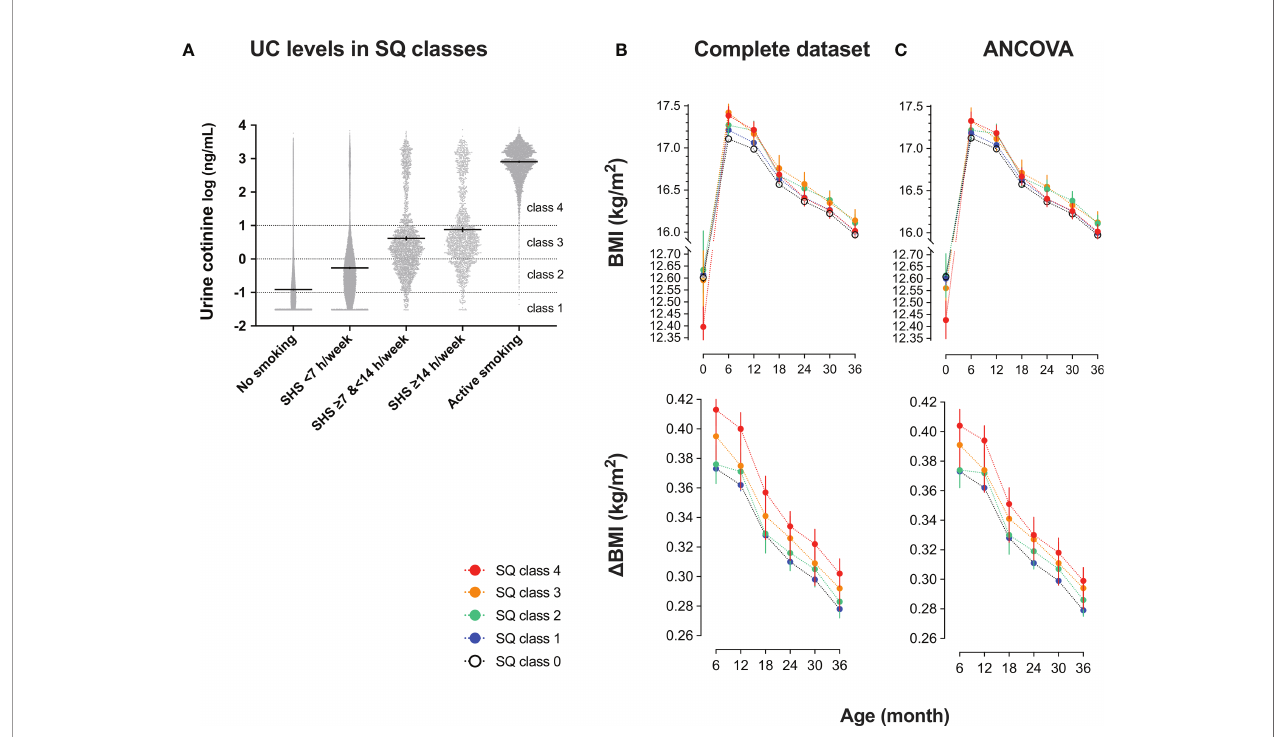
FIGURE 3 | Urinary cotinine (UC) levels during pregnancy and trends in body mass index (BMI) of 35829 list-wise participants in classes by smoking questionnaire (SQ) (A) UC levels in SQ classes. Participants were categorized into fi ve SQ classes for active and second-hand smoking: SQ class 0 (no active nor second-hand smoking); SQ class 1 (second-hand smoking, <7 hours/week); SQ class 2 (second-hand smoking, ≥ 7 hours, and <14 hours/week); SQ class 3 (second-hand smoking, ≥ 14 hours/week); SQ class 4 (active smoking). According to SQ classes, trends in BMI and the differences from baseline ( D BMI) are shown. Values are shown in (B) complete set (n = 35829) and (C) complete set plus repeated measured analysis of covariance corrected by covariates: mother ’ s age at delivery (years), pre-pregnancy BMI (kg/m 2 ), regular alcohol drinking (yes or no), hypertension (yes or no), diabetes mellitus (yes or no), infant sex, pregnancy period, maternal education of ≥ 16 years (yes or no), paternal education of ≥ 16 years (yes or no), household income (1, <4 million; 2, ≥ 4 million and <8 million; 3, ≥ 8 million and <12 million; 4, ≥ 12 million in Japanese